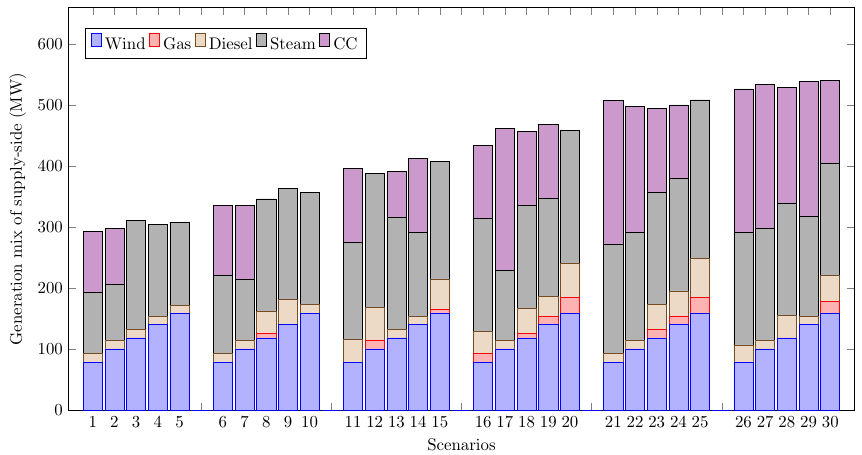
Figure 7. Generation mix scenarios under